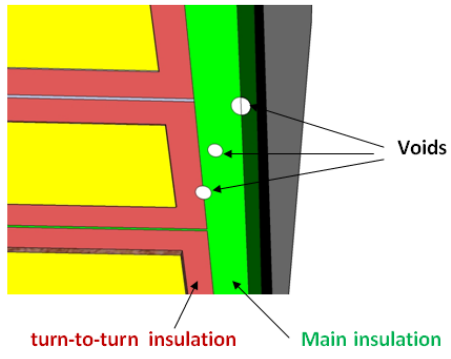
Figure 16. The manufacturing process can bring three types of defect: two at the borders of the main insulation and one localized in the main insulation.